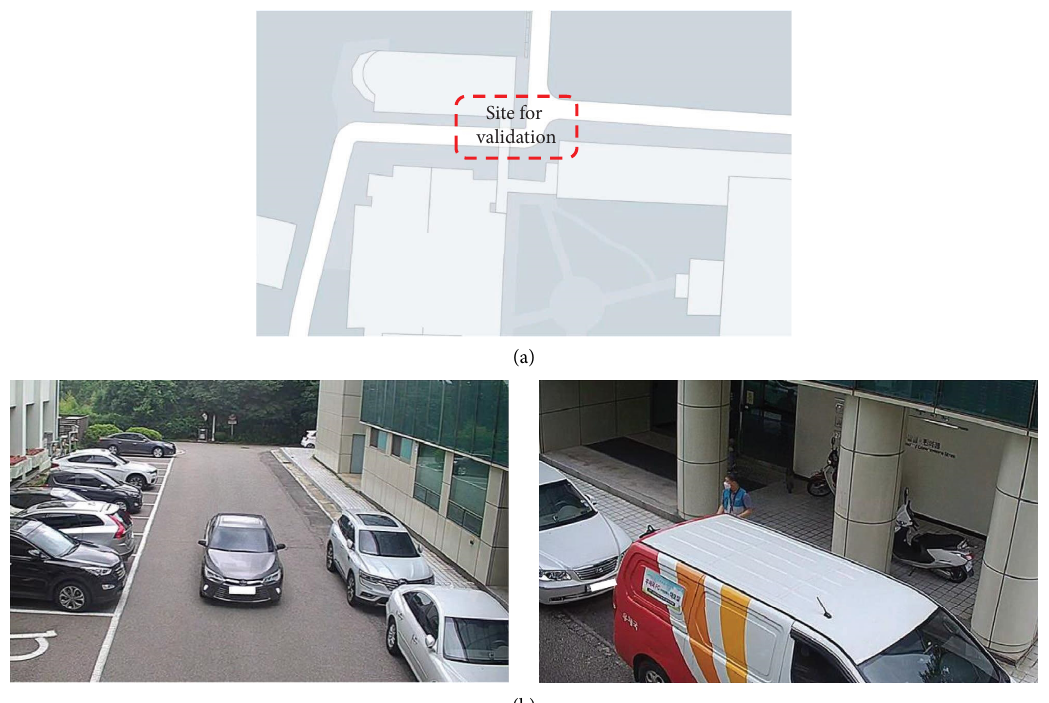
Figure 8: System application (Seoul campus): (a) map of the site for validation and (b) image recorded by a video surveillance camera on Seoul